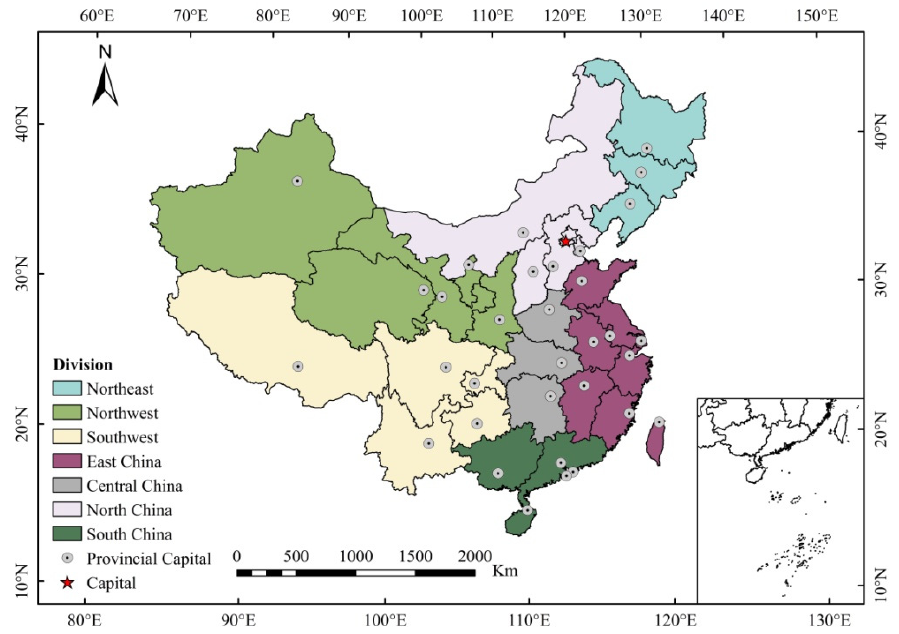
Figure 2. The map of spatial distribution in seven regions over China.